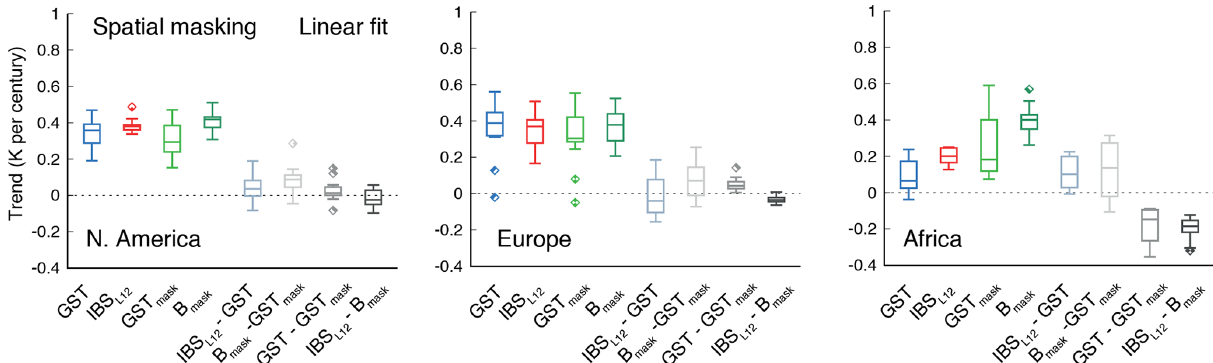
Figure 4. As in Fig. 3 (right) but with the masked cases (i.e., GST mask or B mask ) including only spatial masking. Linear fit estimated 1900– 2005CE trends in the ALL- F ensemble for North American, European and African regions shown in Fig. 3. Abbreviations for GST and PPE cases and their differences follow the same convention as in Figs. 2 and